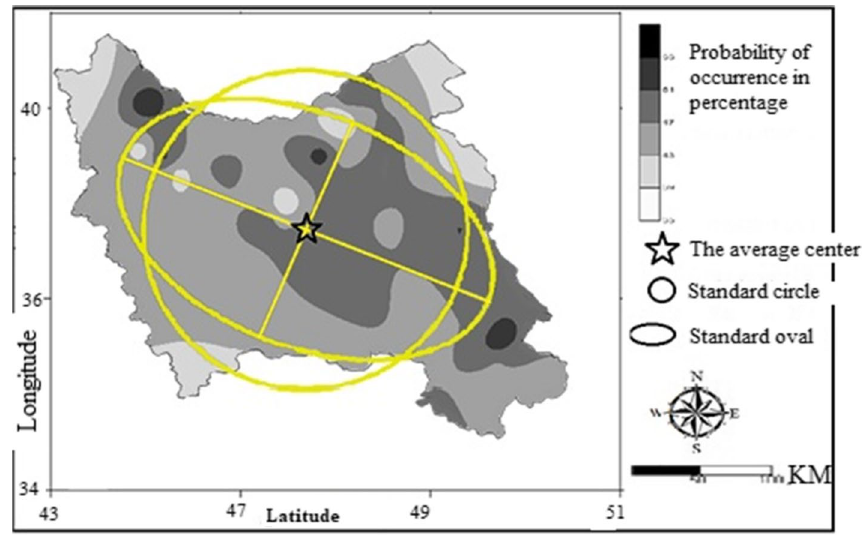
Fig. 7 Probability of severe drought and its distribution and central indices in northwest of